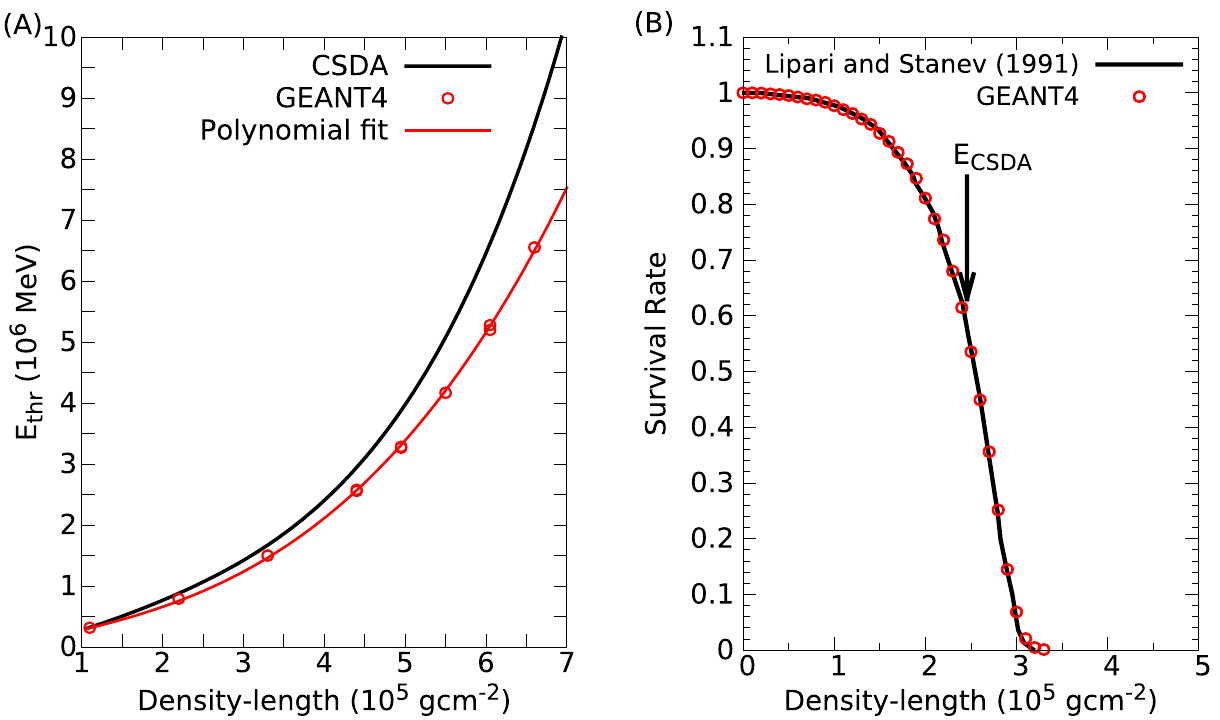
Figure 8. The threshold energies of muons were quantified with GEANT4 simulation. ( A ) The continuous- slowing-down-approximation 53 (CSDA, black line) and the simulated threshold energies (red circles) are shown for silicon dioxide. Red line shows the fitted polynomial function. ( B ) The survival rates of muons with an energy of 1 TeV through standard rock were found in agreement for data produced by Monte Carlo simulations presented in Ref. 56 (black line) and GEANT4 (red circles). Black arrow shows the range of 1 TeV muon in standard rock quantified by